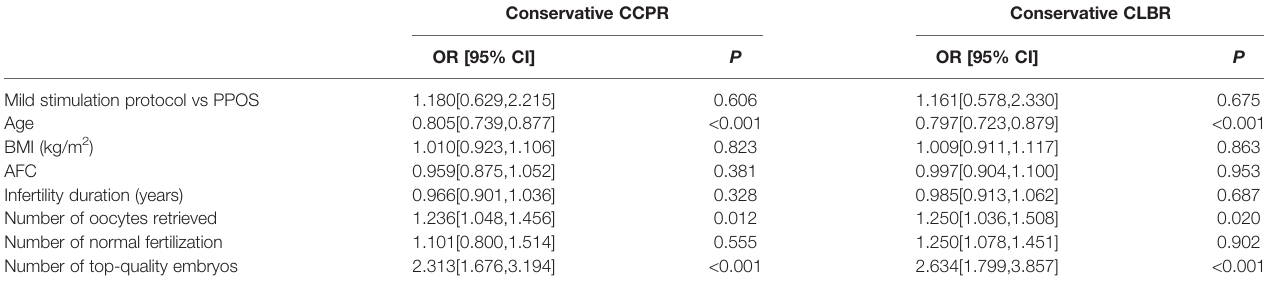
TABLE 5 | A multivariate logistic regression analysis of conservative CCPR and conservative CLBR in patients.